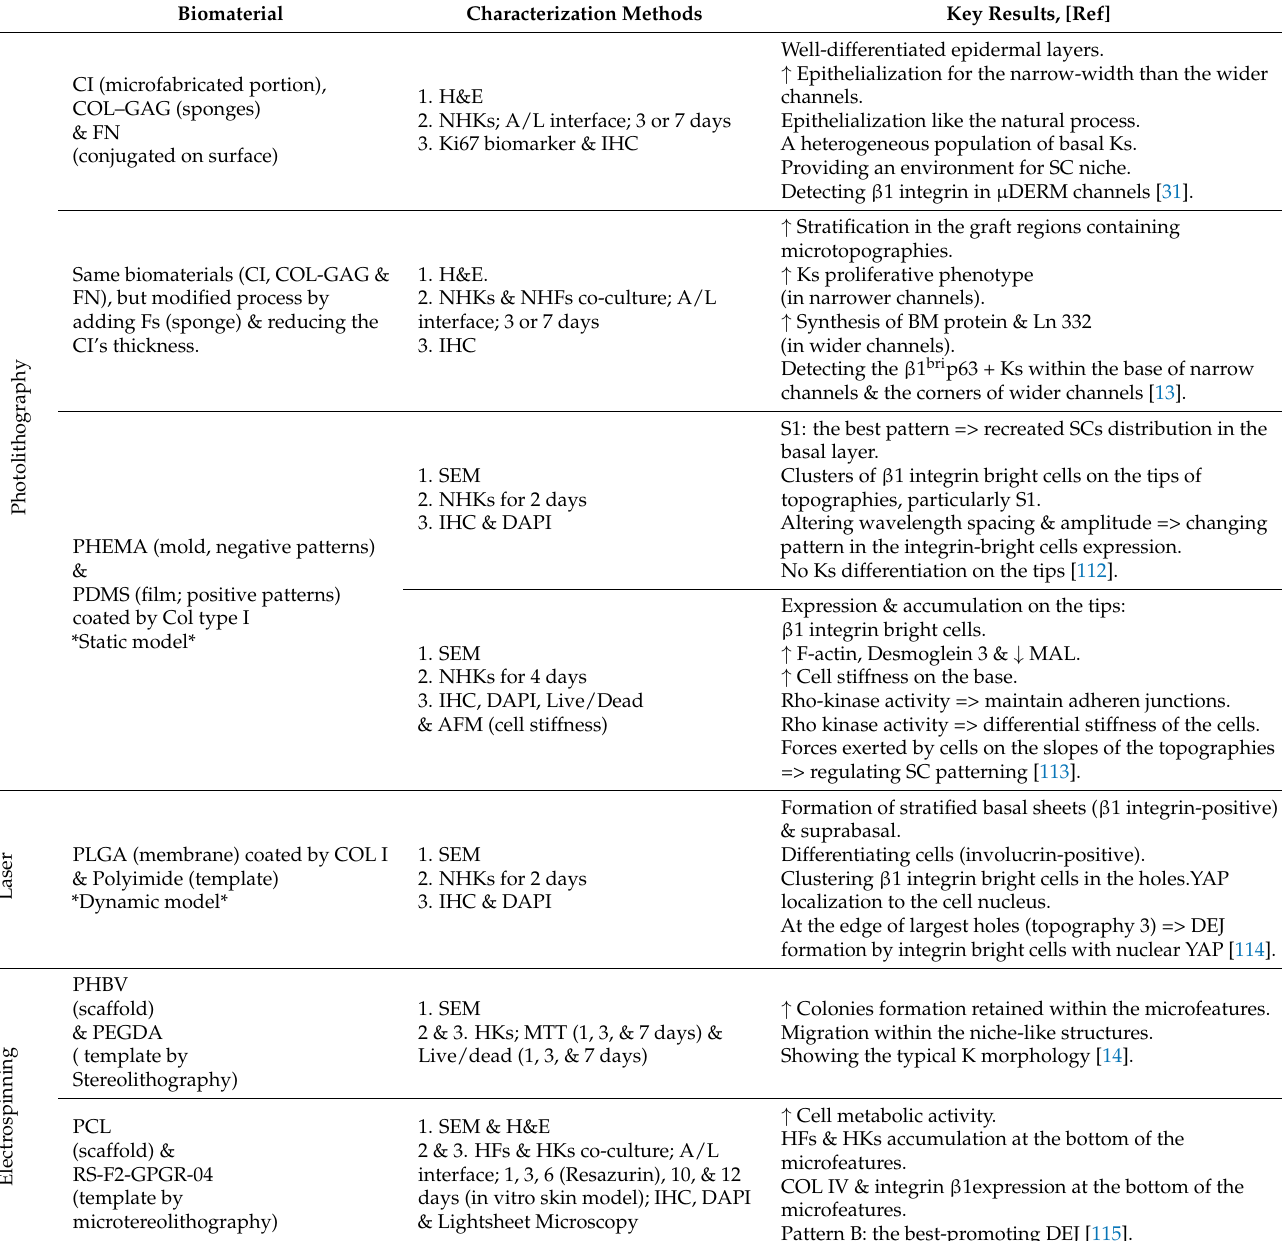
Table 2. Lists of different efforts to mimic the anatomical features of DEJ. Abbreviations: CI, Acid-soluble type I collagen; COL, Collagen; GAG, Glycosaminoglycan; FN, Fibronectin; H&E, Hematoxylin and eosin staining; NHKs, Neonatal primary human keratinocytes; NHFs, Neonatal primary human fibroblasts; HFs, Human dermal fibroblasts; HKs, human epidermal keratinocytes; Ks, Keratinocytes; Fs, Fibroblasts; SC, stem cell; PHEMA, Poly hydroxyethyl methacrylate; PLGA, Poly(d,l- lactide-co-glycolide); PEGDA, Polyethylene glycol diacrylate; PHBV, Poly(3-hydrroxybutyrate- co -3-hydroxyvalerate); PCL, Polycaprolactone; anti, Antibody; DAPI, 4 (cid:48) ,6-diamidino-2-phenylindole; IHC, Immunohistochemistry; CEAs, Cultured epithelial autografts; TEWL, transepidermal water loss; IM, Immunodeficient mice; Assays: 1. Microtopographic analysis; 2. Cell type, culturing system and days; 3. Cellular investigations; 4. In vivo study; ↑ , Improved or Higher; ↓ , Decreased or Lower; =>, Resulted